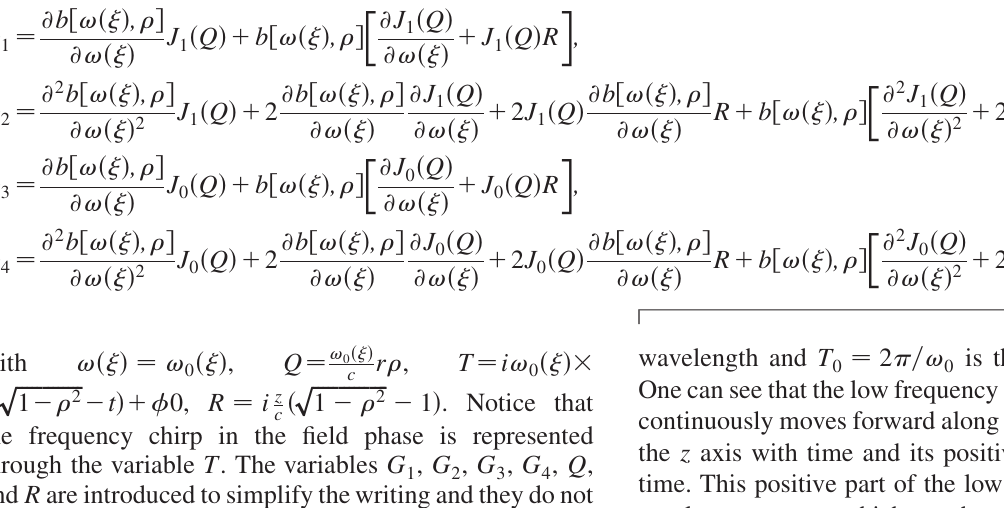
FIG. 1. The normalized axial electric field E (d). The laser parameters are with the waist radius w 13 T 0 parameter C ¼ 0 : 006 42